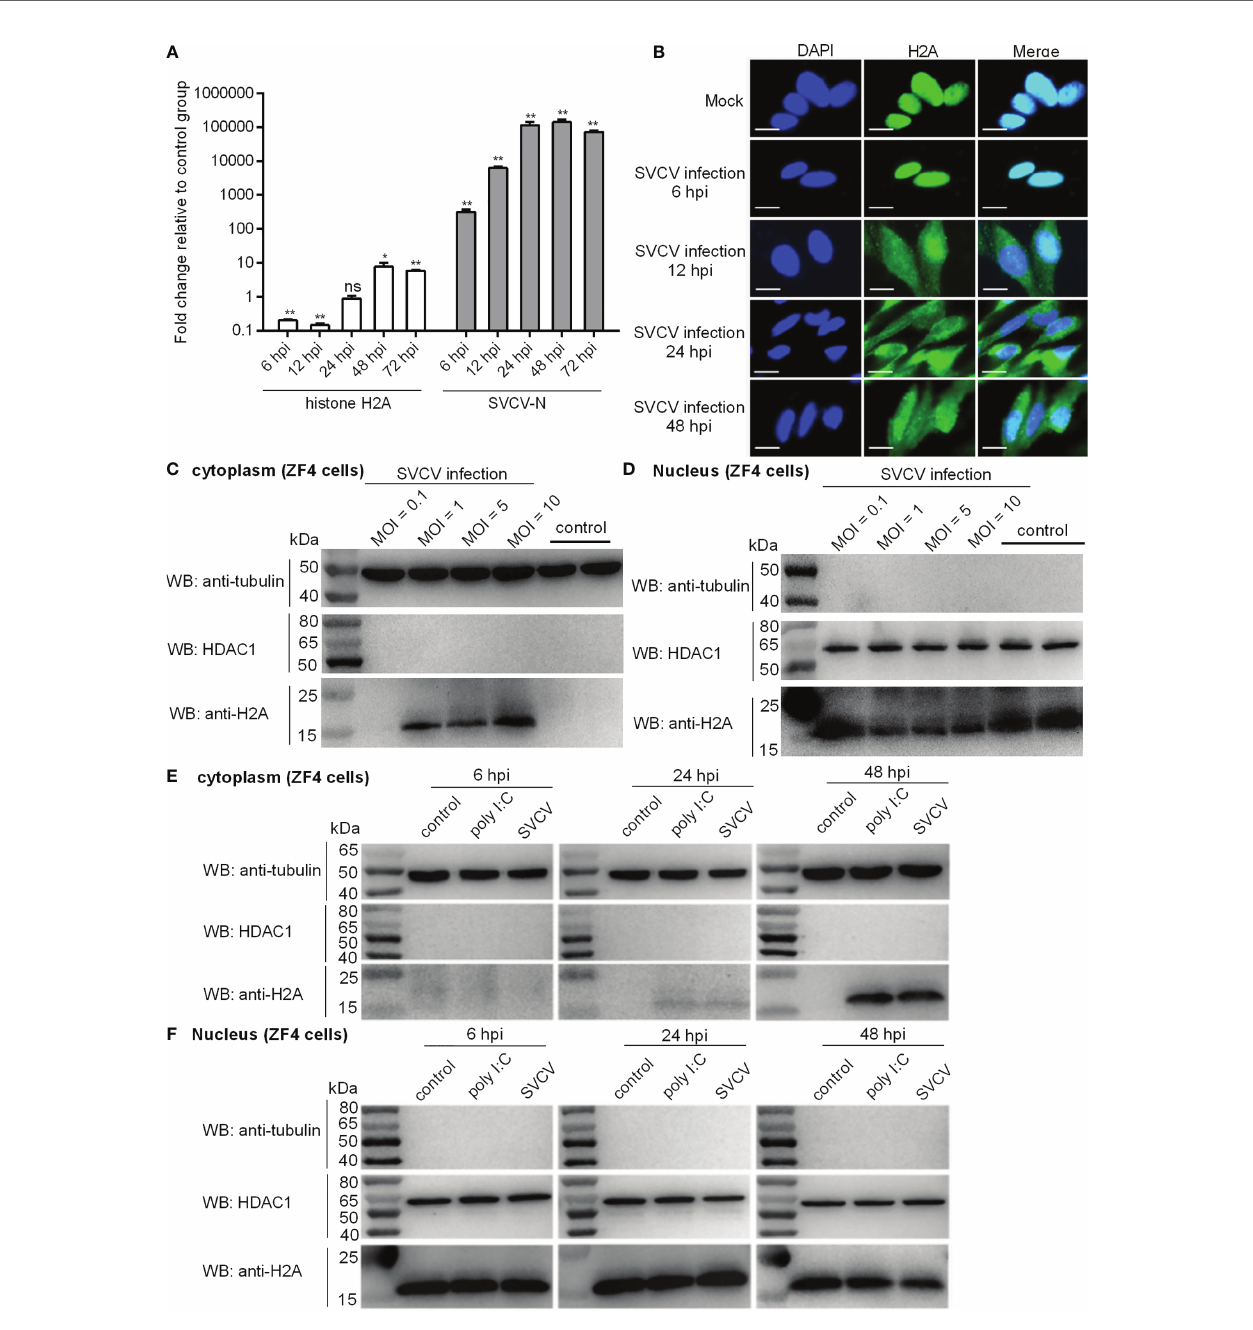
FIGURE 1 | Expression and subcellular localization of zebra fi sh histone H2A. (A) The expressions of histone H2A and SVCV-N in zebra fi sh larvae in response to SVCV infection. Total RNA was extracted from zebra fi sh larvae collected at 6, 12, 24, 48 and 72 hpi. Data represented means ± SEM (n = 3), and were tested for statistical signi fi cance. * p < 0.05; ** p < 0.01; ns, not signi fi cant. (B) Subcellular localization of zebra fi sh histone H2A by immuno fl uorescence analysis in the mock- infected and SVCV-infected ZF4 cells. Scale bar: 10 m m. (C) Cytoplasmic fractions from the mock-infected and SVCV-infected ZF4 cells. (D) Nuclear fractions from the mock-infected and SVCV-infected ZF4 cells. For (C, D) , ZF4 cells cultured in 6-well plates overnight were infected with SVCV at an MOI of 0.1, 1, 5 and 10. At 24 hpi, the cells were harvested and used for preparation of nuclear and cytoplasmic extracts. (E) Cytoplasmic fractions from SVCV-infected, poly I:C-stimulated and untreated ZF4 cells. (F) Nuclear fractions from SVCV-infected, poly I:C-stimulated and untreated ZF4 cells. For (E, F) , ZF4 cells passed in 6-well plates overnight were infected with SVCV at an MOI of 1 or stimulated with poly I:C (10 m g/mL) or left untreated. At 6, 24 and 48 hpi, the cells were harvested and used for preparation of nuclear and cytoplasmic